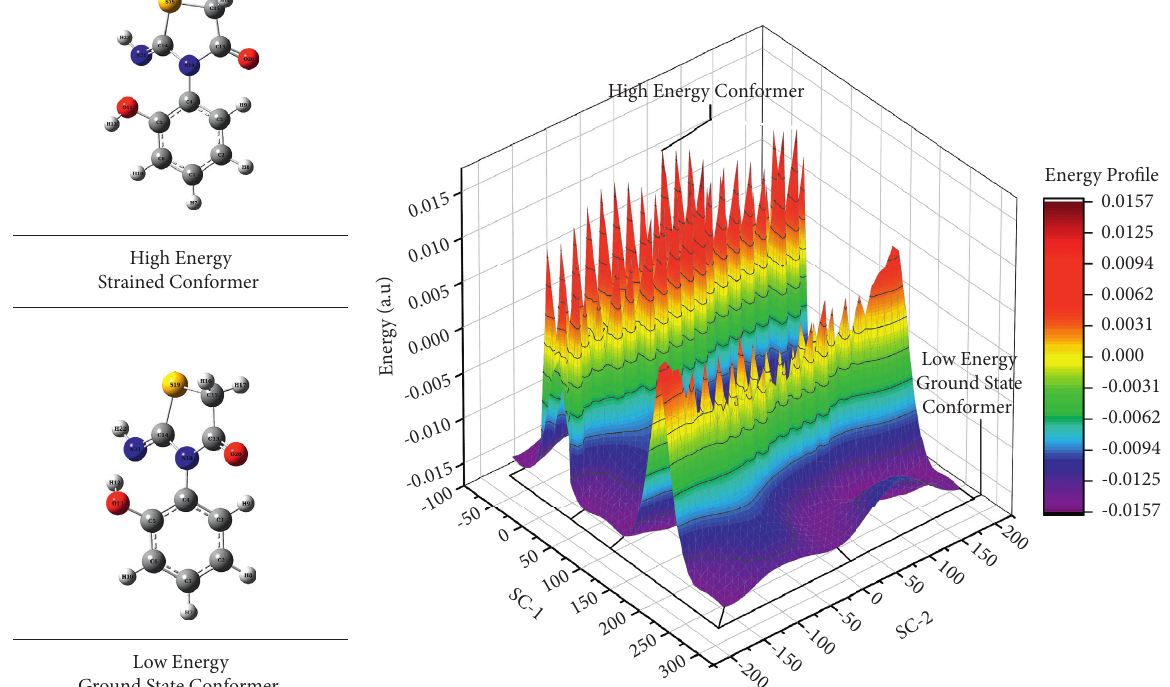
Figure 2: 3D scan coordinates on SC1 and SC2 with respect to energy using AM1